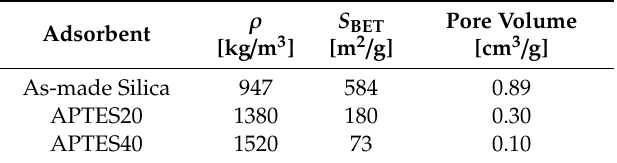
(BJH) pore volume of the adsorbent particles.